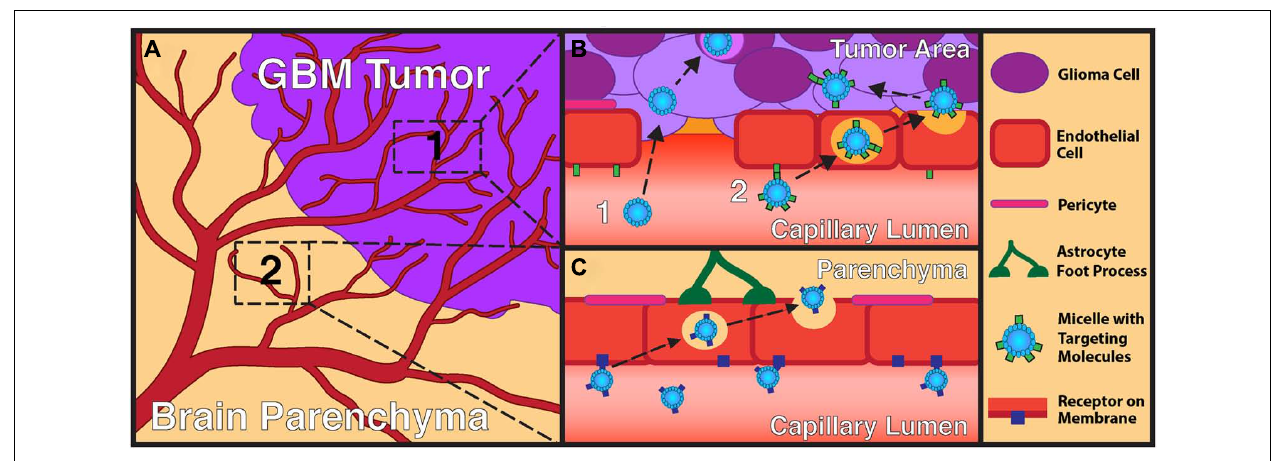
parenchyma. Examples of receptors more specific to the tumor vasculature and glioma cells include α v β 3 integrin and aminopeptidase N. (C) Close-up of normal vasculature with surrounding normal brain parenchyma. Here, micelles can interact with the intact BBB, allowing for transcytosis of particles. An example of a receptor mediating this pathway includes the Tf receptor. While receptor-mediated endocytosis is displayed in these images, other endothelial cell uptake mechanisms such as adsorptive-mediated endocytosis may take place at these sites as